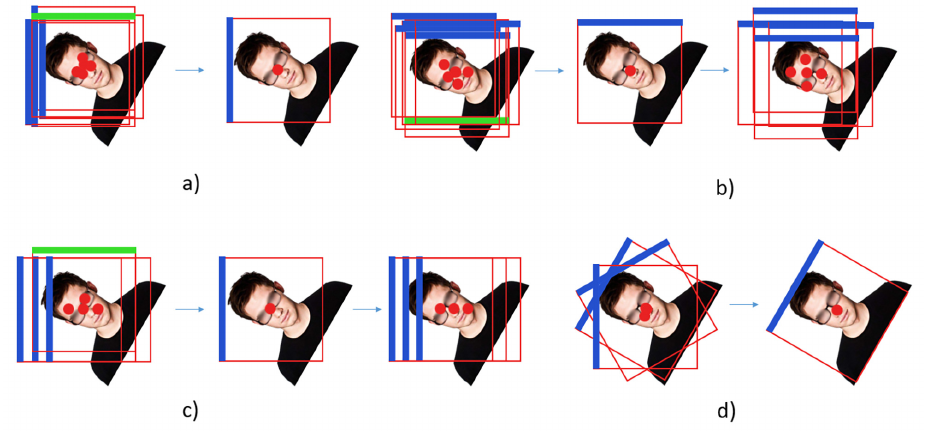
Figure 4. The process of CC, where the red dot represents the center of the bounding box, the blue line represents the true direction predicted by the detector, and the green line represents the error direction predicted by the detector: ( a ) the cluster method at the center of the bounding box; ( b ) the first stage of the network in order to correct all the angles of the output of the first stage by accumulating the most detected angles in the cluster; ( c ) the second stage of the network; and ( d ) the third stage of the display network, where the angle of the final prediction is calibrated by finding the most reliable position of the